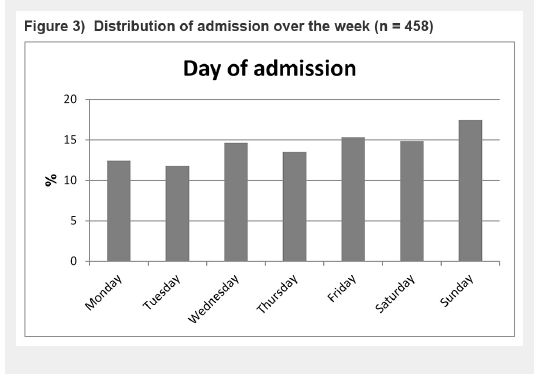
Distribution of admissions over the week (n = 458).